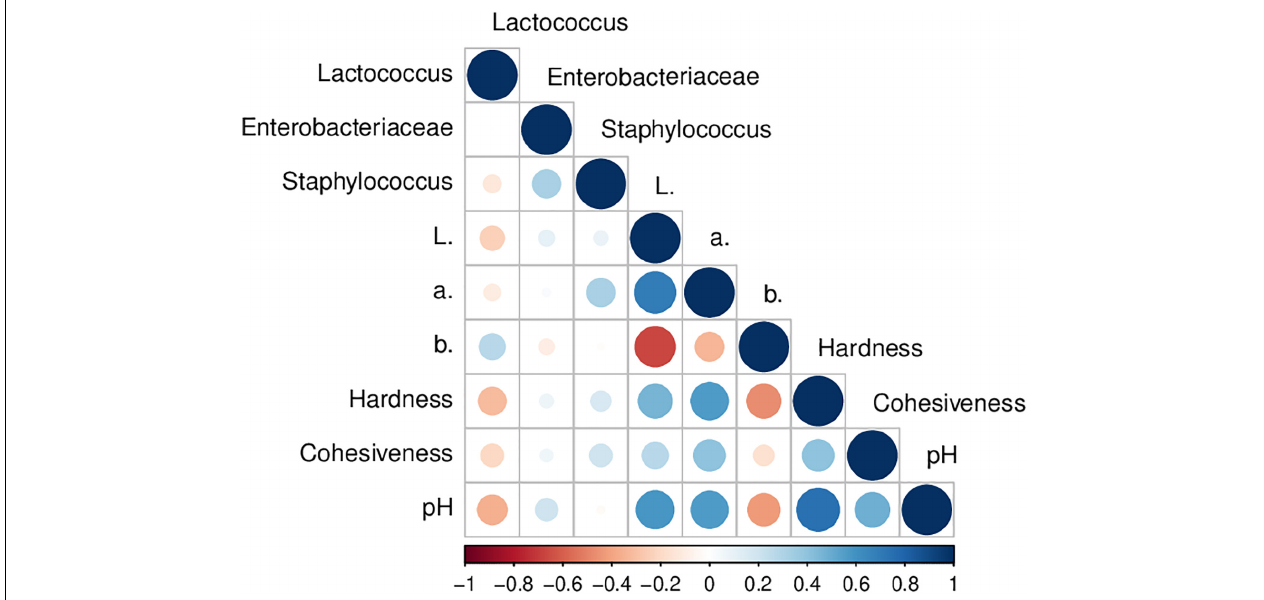
FIGURE 3 | Pearson’s correlation coefficients among physicochemical and microbial quality parameters of raw goat milk cheeses stored at 4 ◦ C. Correlations with P -value > 0.05 are considered